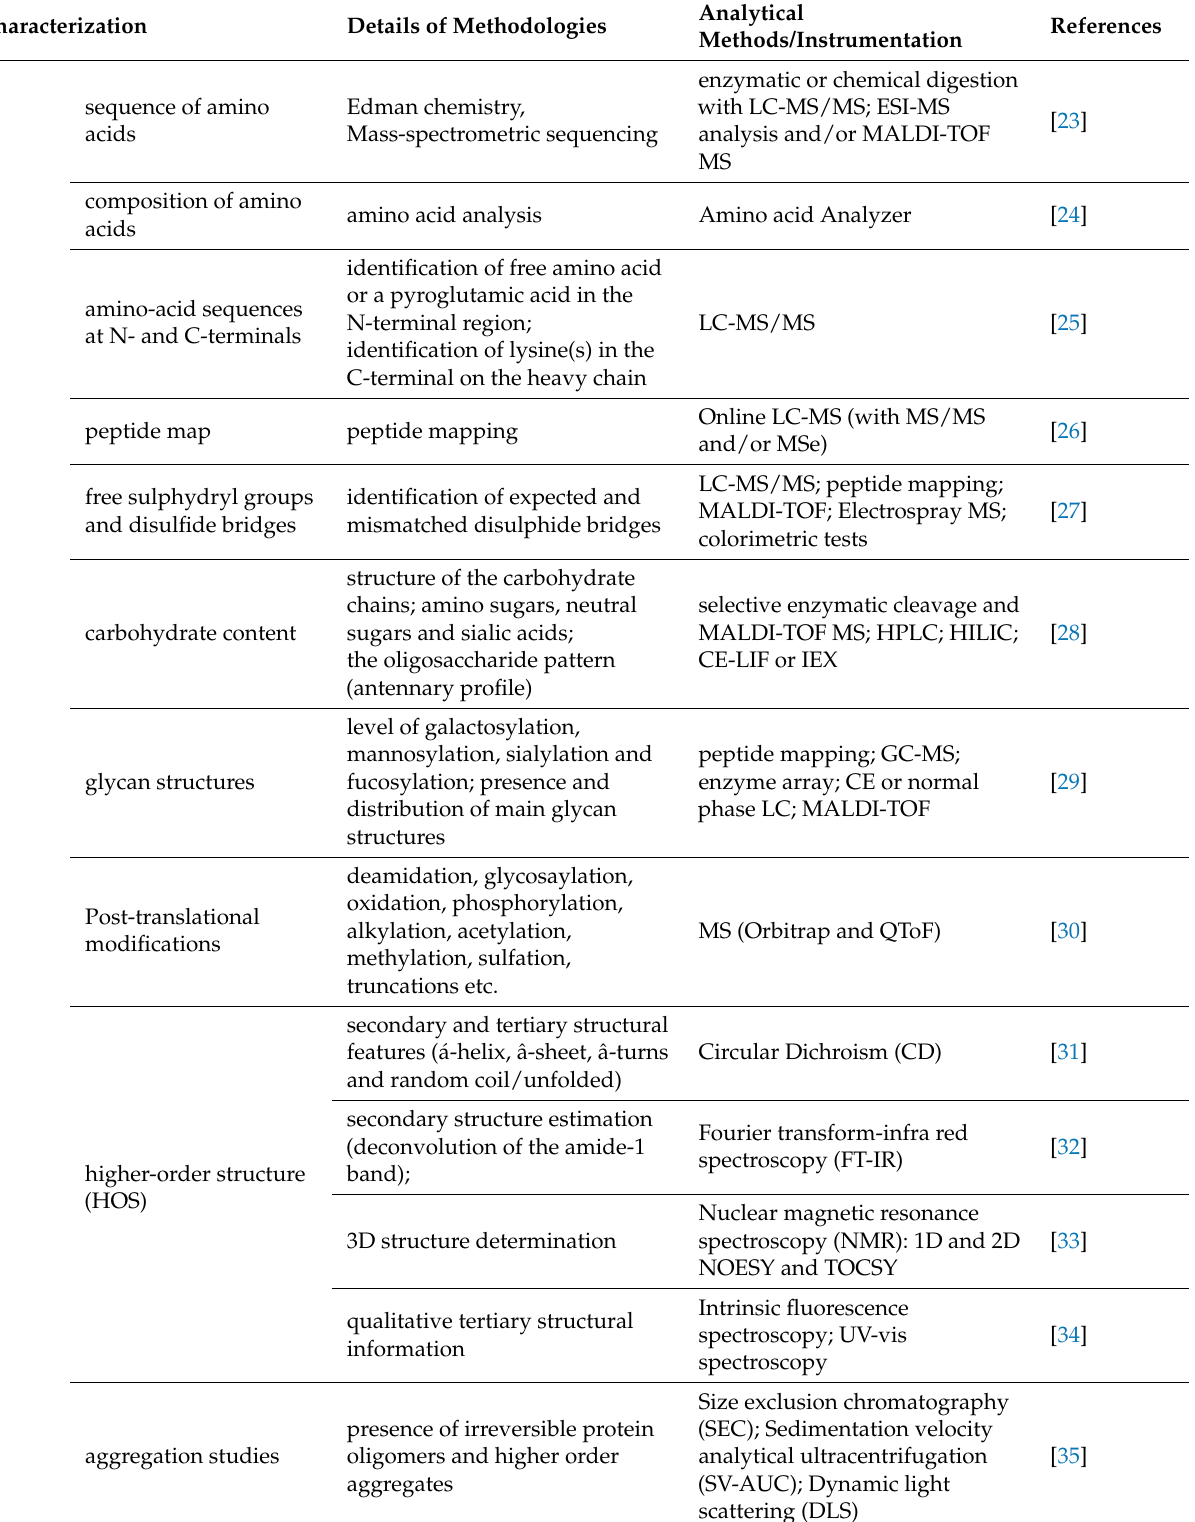
Table 1. Methodologies and instrumentation for characterization of monoclonal